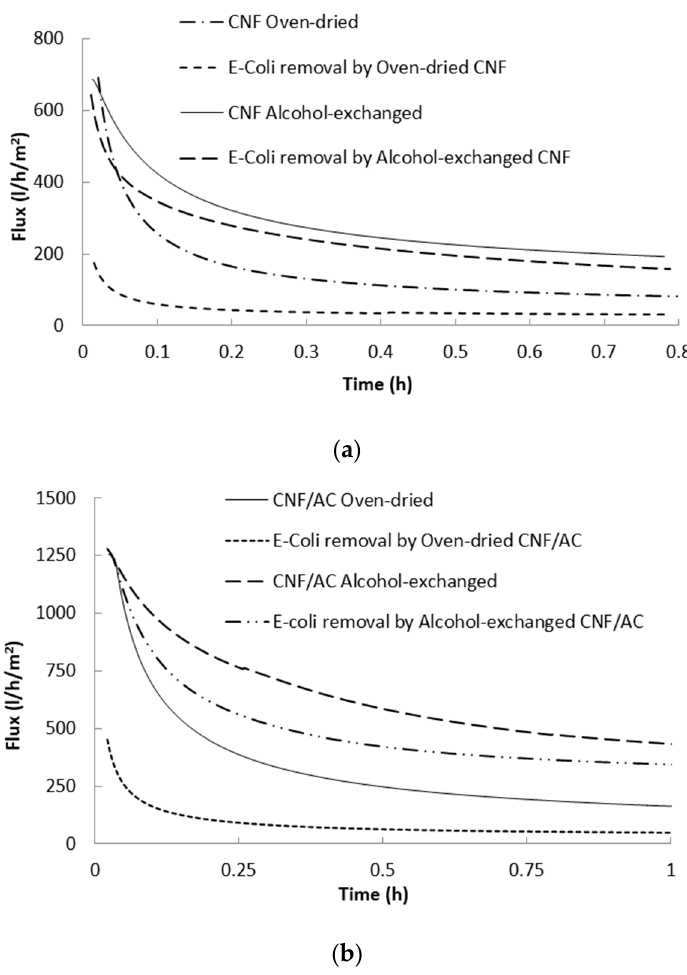
Figure 6. Flux of pure water and E. coli bacteria suspension by CNF ( a ) and CNF/AC ( b ) membranes.